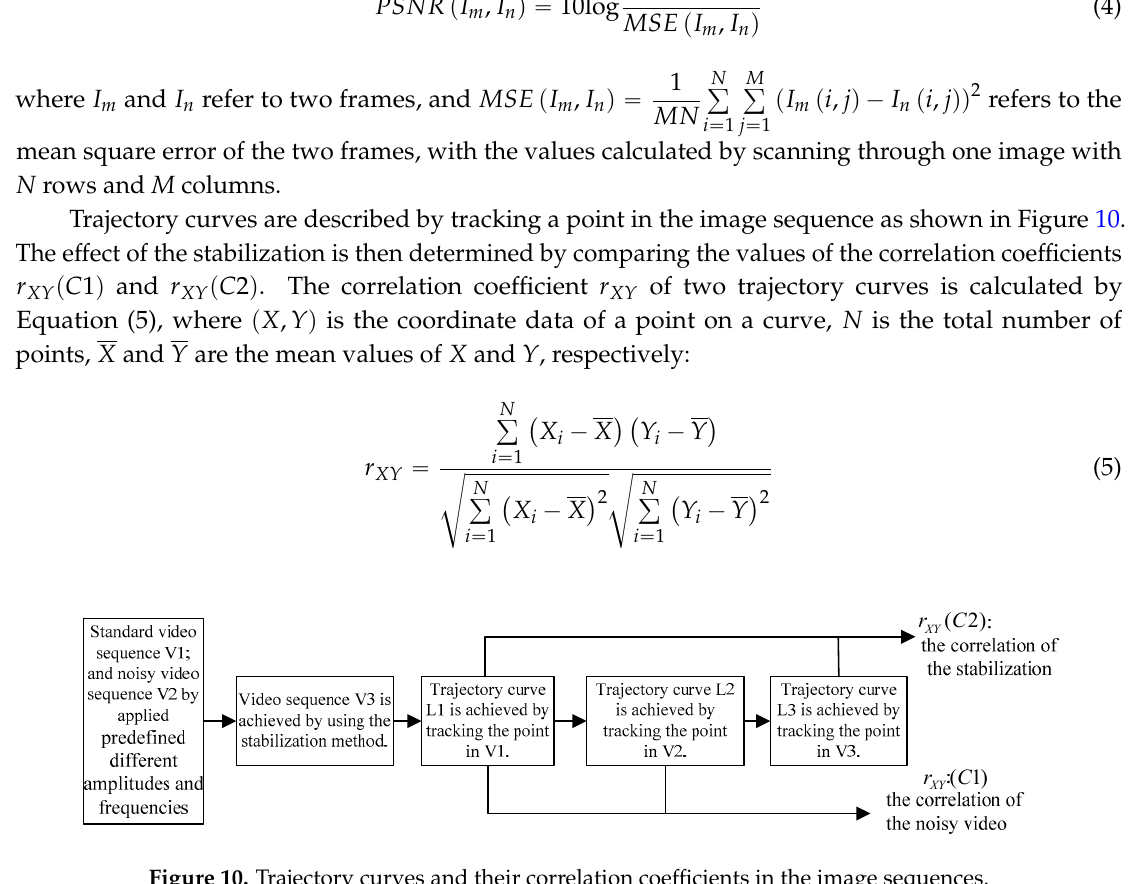
Figure 10. Trajectory curves and their correlation coefficients in the image sequences.